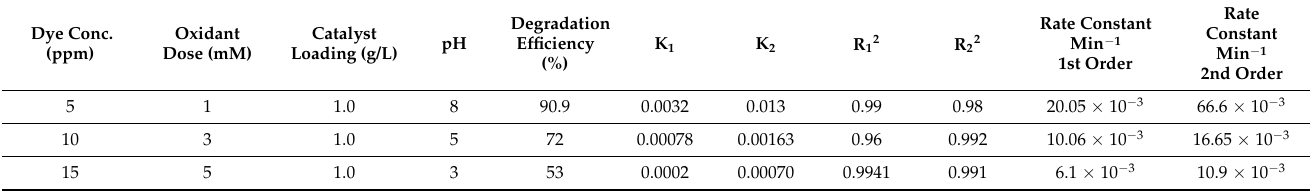
Table 5. Effect of pH, oxidant dose, dye concentration, and time on dye degradation efficiency. Dye Conc. Oxidant Catalyst (ppm) Dose (mM) Loading (g/L)